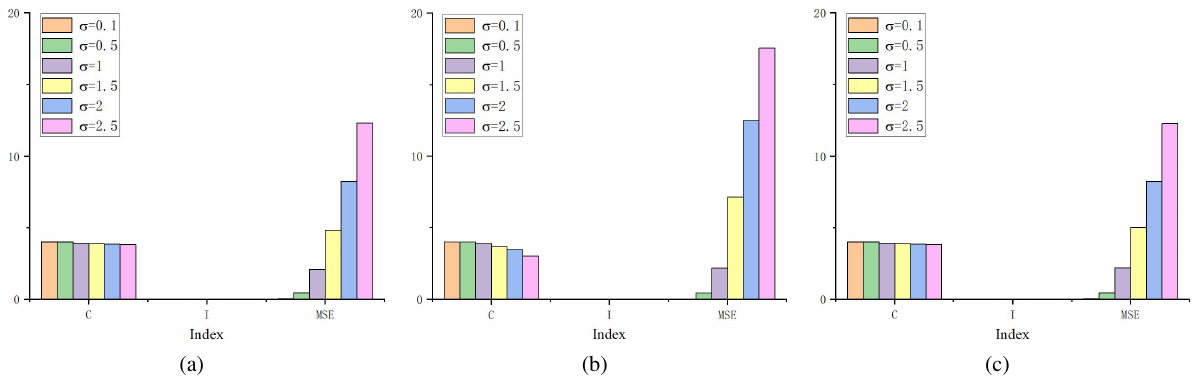
Fig. 7 Simulation results when N = 400, R = 30 and ρ = 0.5. (a) The result of ALASSO penalty function; (b) the result of LASSO penalty function; and (c) the result of SCAD penalty function. ALASSO, adaptive least absolute shrinkage and selection operator; LASSO, least absolute shrinkage and selection operator; SCAD, smoothly clipped absolute